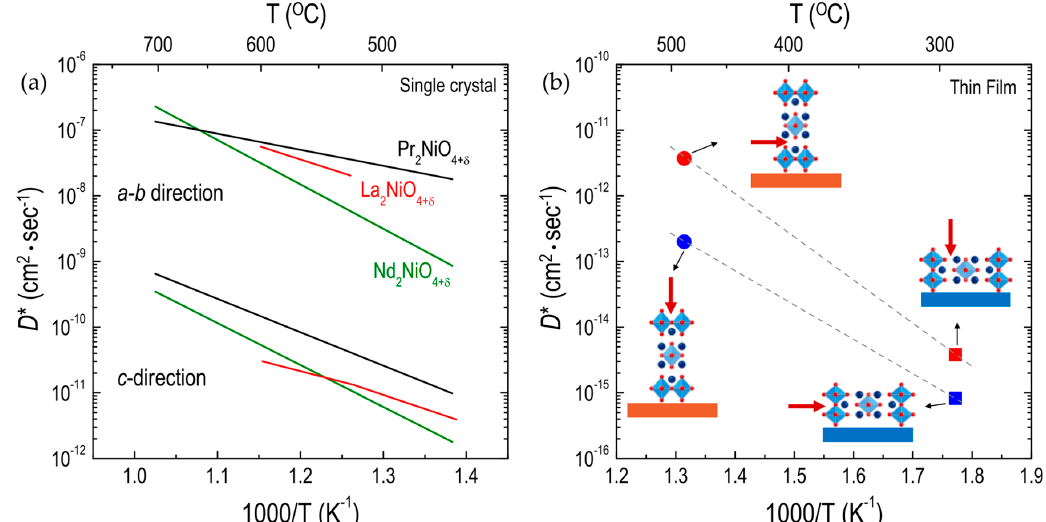
Figure 8. Arrhenius plots of oxygen tracer diffusivity ( D *) for different RP oxides: ( a ) D * along the a-b plane and c -direction in A 2 NiO 4+ δ (A = Pr, La, and Nd, Refs. [49,97]) single crystalline oxides; and ( b ) D * along the a-b plane and c -direction in the (001)-oriented (circle) and the (100)-oriented (square) La 1.75 Sr 0.25 CoO 4+ δ thin films [109].